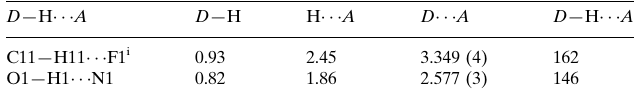
Hydrogen-bond geometry (A˚ , (cid:2)